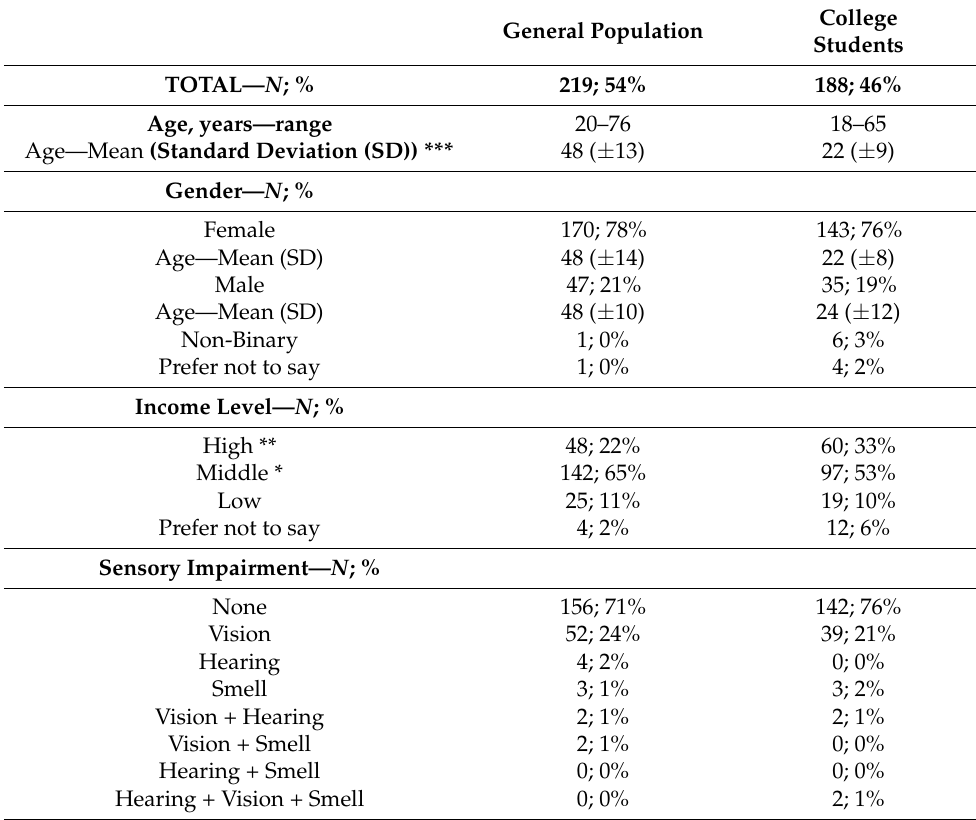
Table 1. Subject Characteristics by General Population and College Student